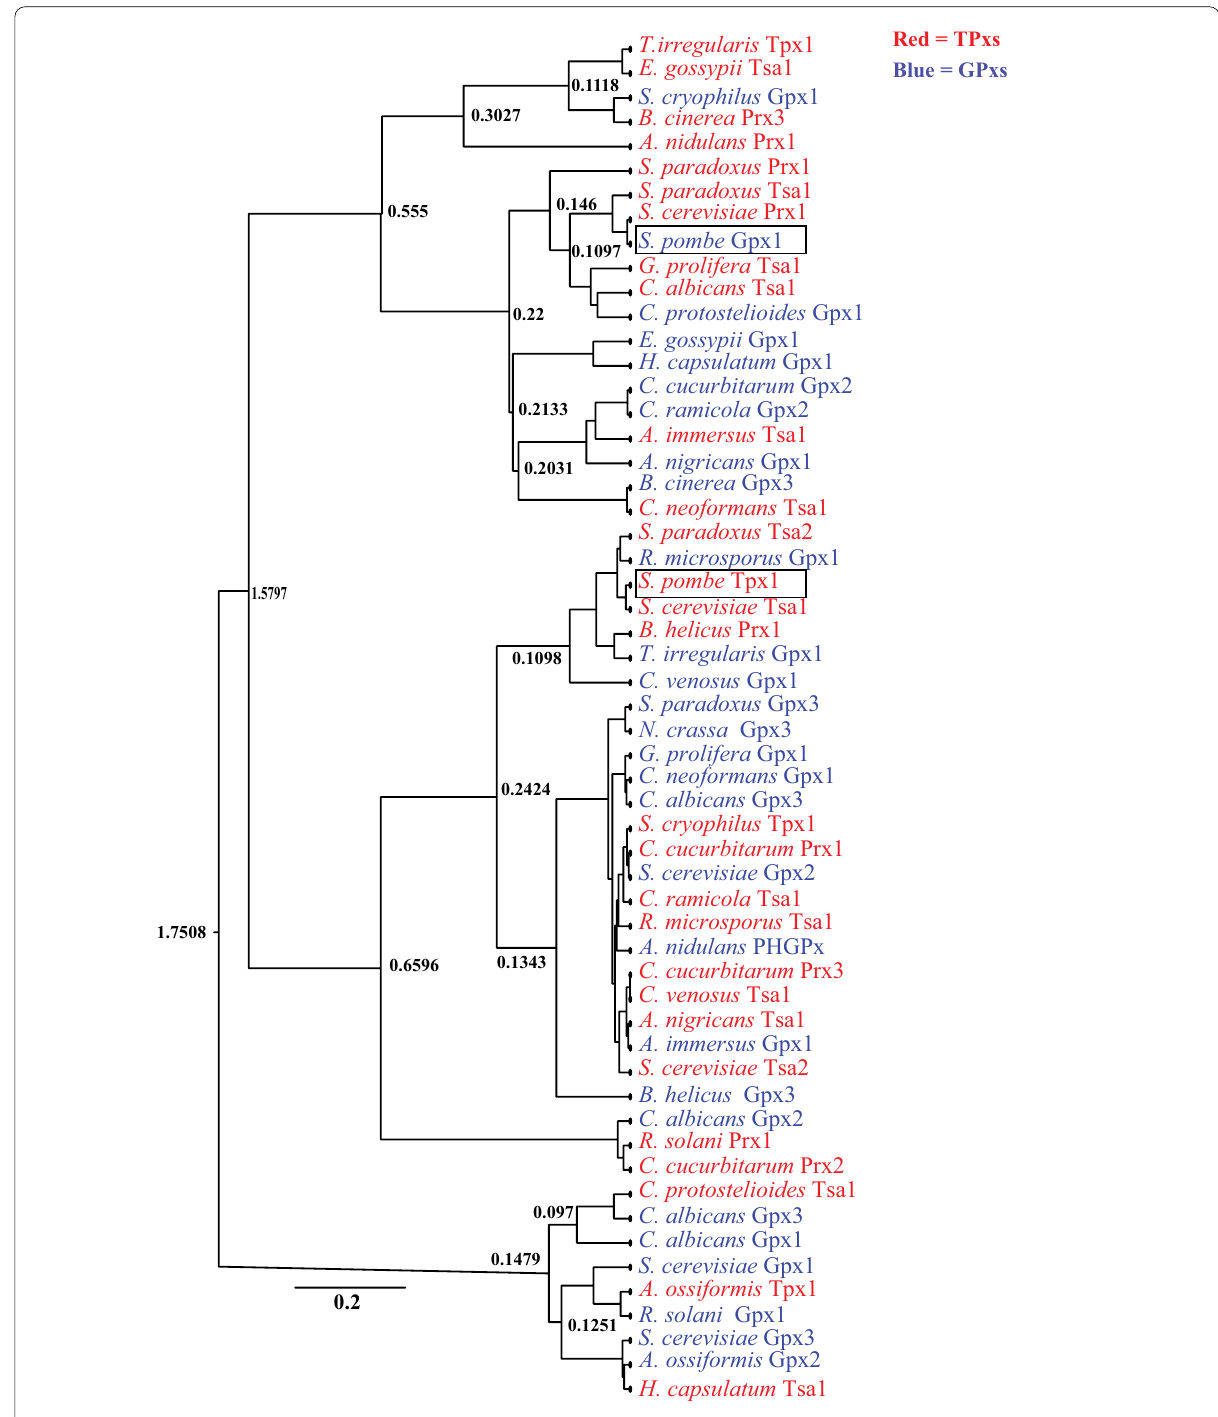
Fig. 5 Bayesian evolutionary tree of fungal GPxs and TPxs using BEAST analysis. GPxs are colored in blue, and TPxs are colored in red. The strict clock model was used in the analysis. The reliability of nodes in the phylogeny was assessed using the MCMC algorithm. Bayesian posterior probabilities are shown at the nodes. The scale bar suggests that each site has 0.2 amino acid substitutions. The accession numbers for the proteins are provided in Tables S1 and